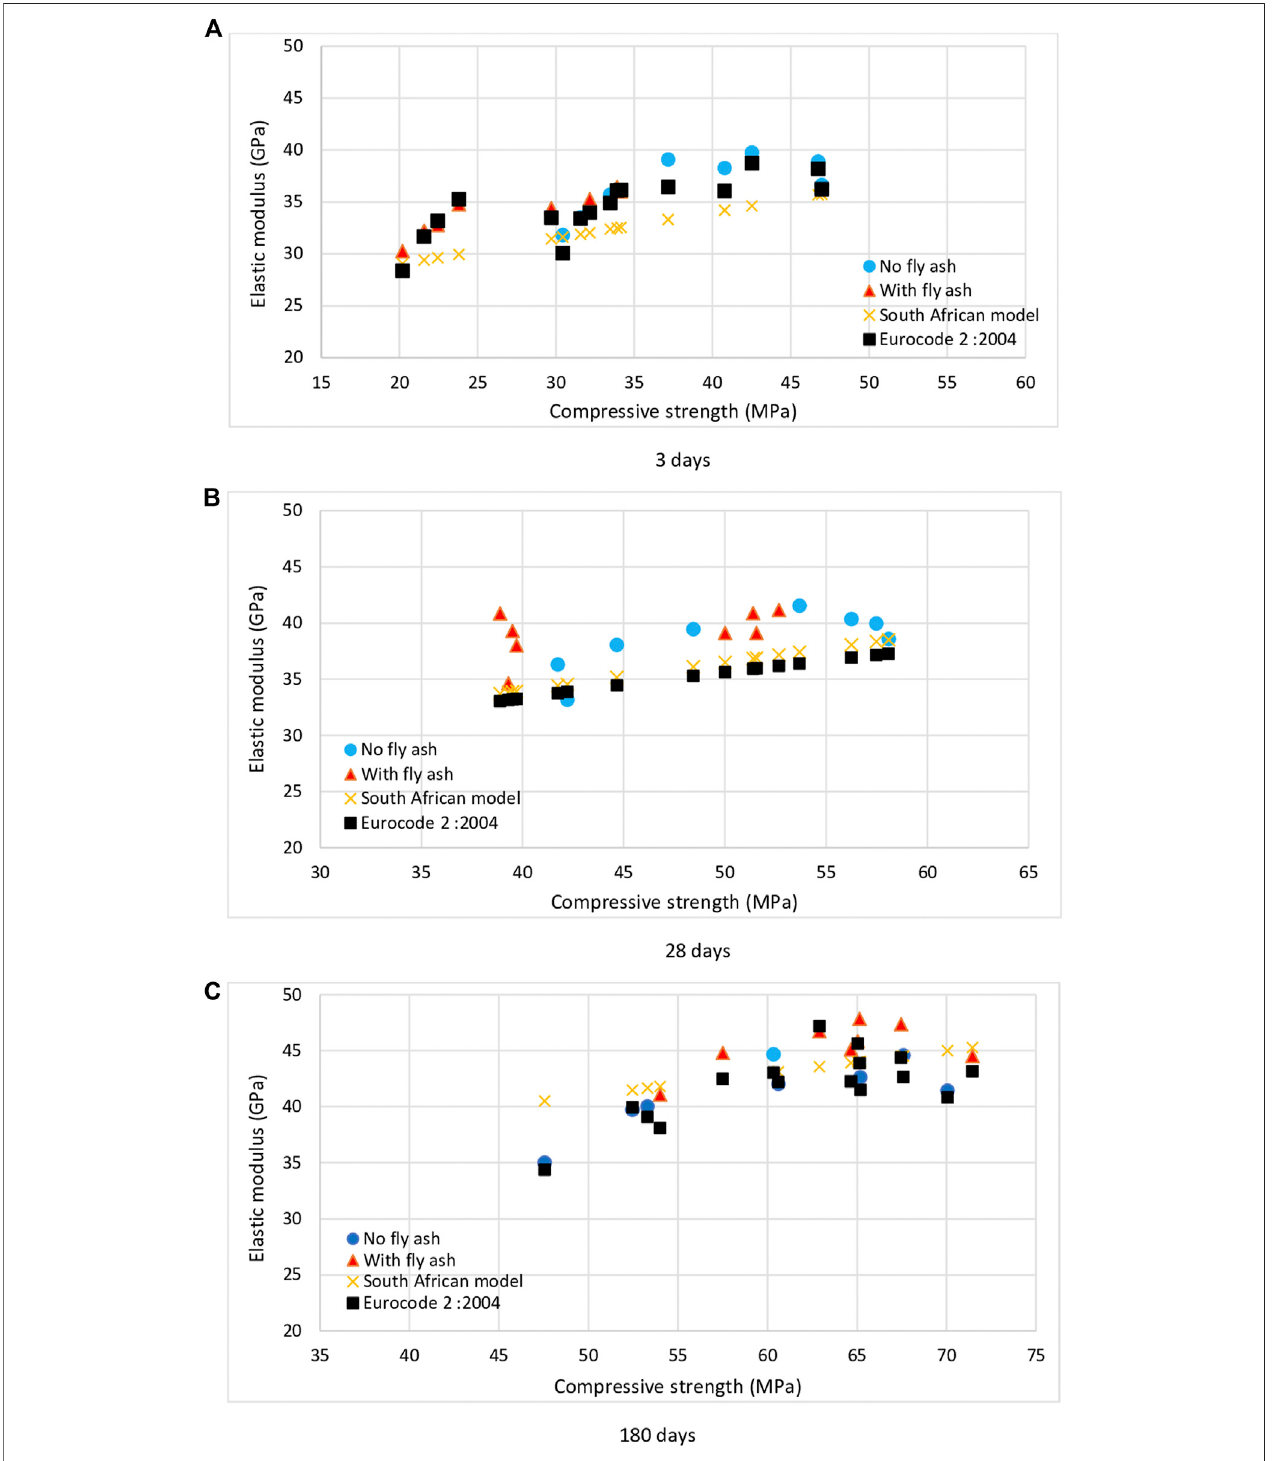
FIGURE10| Relationship betweenelasticmodulusand compressive strength ofFRAconcretemixes atthreetest ages: (A) 3days, (B) 28daysand (C) 180days.